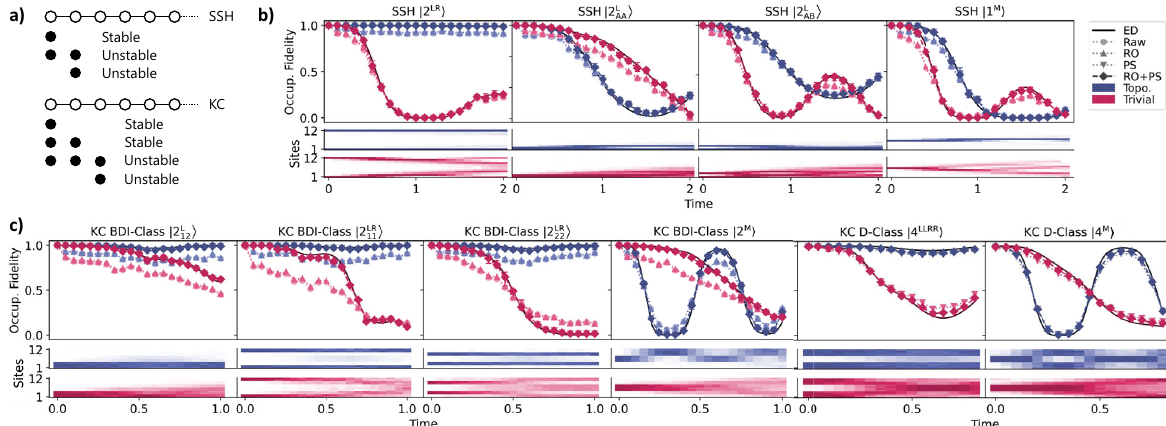
Fig. 2 Multiple fermions on topological chains. a Schematic illustrating the enhanced stability of two-fermion edge states in H KC as compared to H SSH . States not localized at edges are unstable. b 2-fermion time-evolution results for H SSH when ν = 1, with occupancy fi delity (cid:4) (cid:4) (cid:4) (cid:5) (cid:5) (cid:5) (cid:4) (cid:4) (cid:4) , which is perfectly localized on both edges. The left-localized 2 L and 2 L states decay as rapidly as preserved only for the initial state 2 LR (cid:4) (cid:5) AB AA (cid:4) 1 M regardless of topology; indeed it is impossible to construct 2-fermion robust states localized on a single edge. c In contrast, H KC in the (cid:4) (cid:5) (cid:4) state, as well as various other states localized at both edges. Up to 4 fermions BDI-class ν = 2 phase stabilizes the left-localized 2-fermion 2 L (cid:4) (cid:5) (cid:4) can occupy the fourfold topological modes of H KC , as demonstrated in the D-class on 4 LLRR . In contrast to the non-topological middle- (cid:4) (cid:4) (cid:5) (cid:5) (cid:4) (cid:4) localized 4 M , the boundary-localized 4 LLRR is greatly stable. Time-evolution results are for N = 6 unit cells ( n = 12 qubit), with error bars obtained from repeated experiments across different qubit chains and machines ( ibmq_paris , ibmq_toronto , and ibmq_manhattan ). Detailed parameter speci fi cations are given in Table